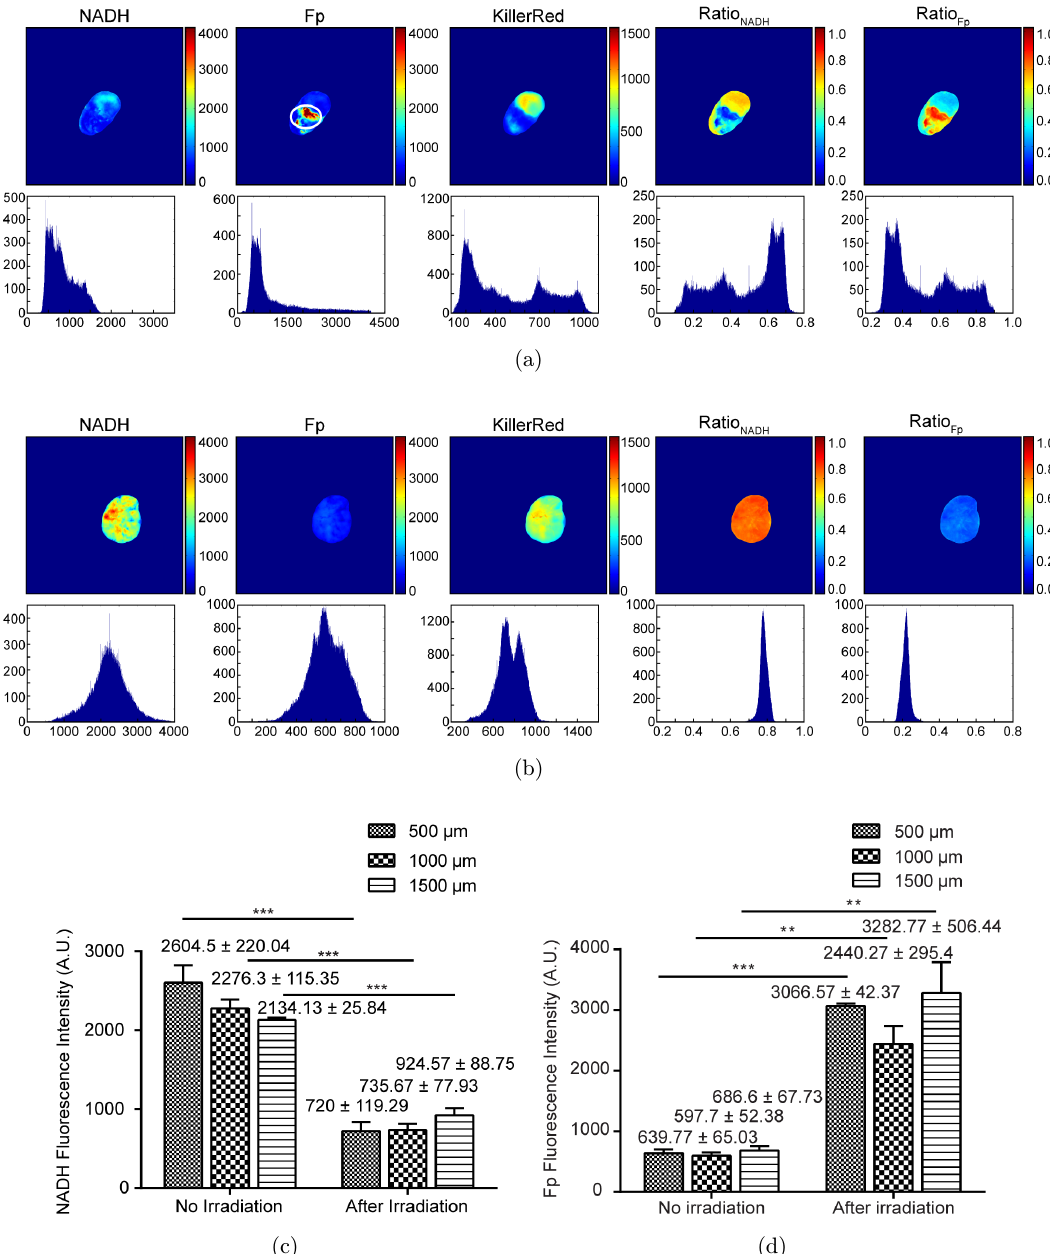
Fig. 4. Cyro-imaging of KillerRed-HT1080 tumor by light irradiation and no irradiation. (a) The cyro-imaging of KillerRed- HT1080 tumor treated by light irradiation. (b) The cyro-imaging of KillerRed-HT1080 tumor with no irradiation. (c) – (f) The quanti¯cation data on °uorescence intensity of Fp at di®erent depth, including 500 (cid:1) m, 1000 (cid:1) m, 1500 (cid:1)